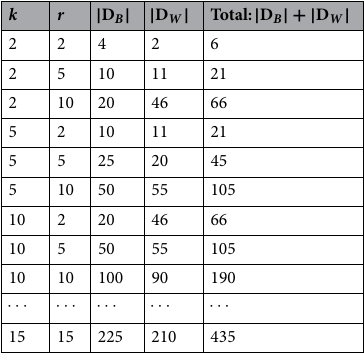
Table 3. Lengths of the vectors D B and D W ( | D B | and | D W | , respectively) for some values of k and r